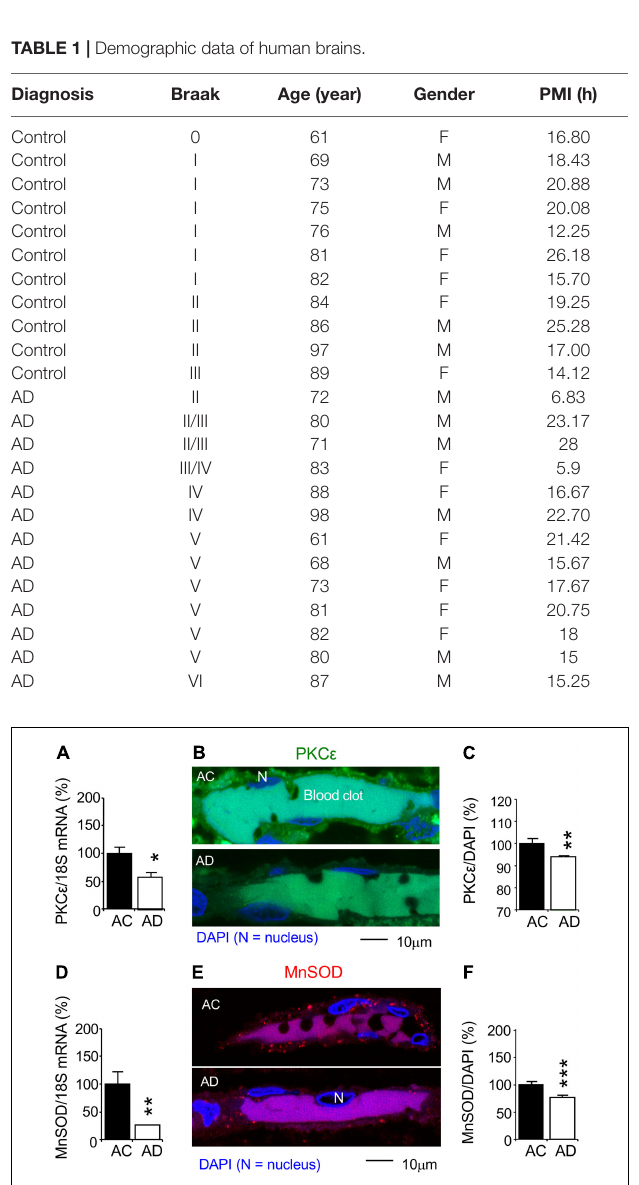
FIGURE 7 | Reduction of PKC ε and mitochondrial MnSOD mRNA and protein expression in the CA1 stratum radiatum of autopsy-confirmed AD human hippocampus. (A,D) Quantitative PCR (qPCR) was used to detect PKC ε mRNA at the whole hippocampus level and (B,C,E,F) immunohistochemistry and confocal microscopy were used to determine protein expression in MV wall cells in hippocampal CA1 area (N, the nucleus of MV wall cell). (A) mRNA and (B,C) protein expression for PKC ε . (D) mRNA and (E,F) protein expression for MnSOD. AC, age-matched control; AD, autopsy-confirmed Alzheimer’s disease. PKC ε and MnSOD mRNA and protein expression were reduced in overall AD brains (Braak stages II–VI), compared to AC controls (Braak stages 0–III). Data are reported as mean ± SEM, ∗ p < 0.05; ∗∗ p < 0.01; ∗∗∗ p < 0.001; two-tailed t -test compared with their according controls ( n = 11 hippocampi per group for qPCR or n = 182–365 random MV cells from 11 hippocampi per group).